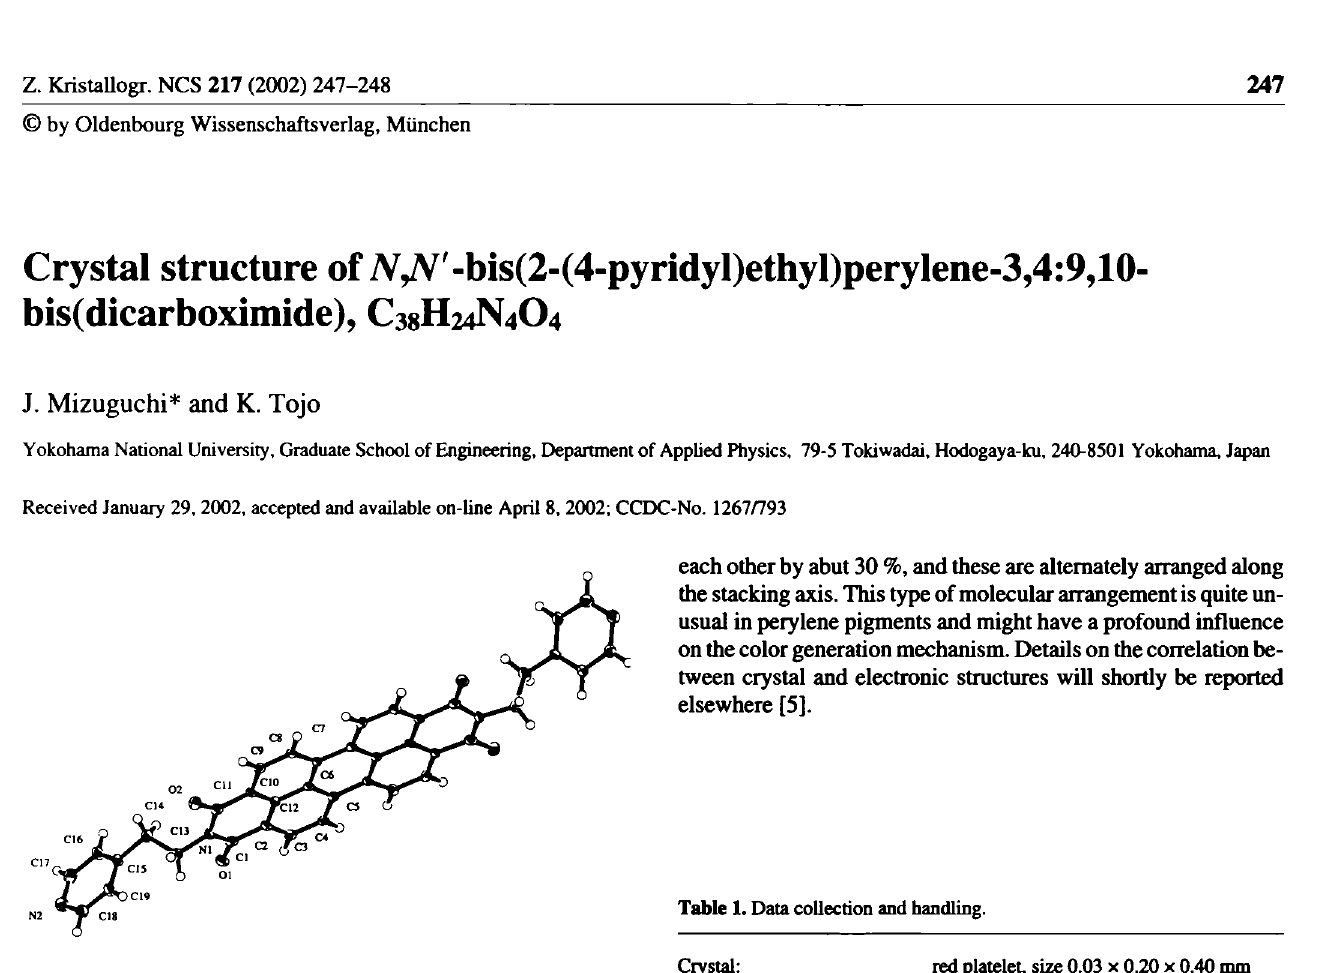
Table 2. Atomic coordinates and displacement parameters (in Â 2